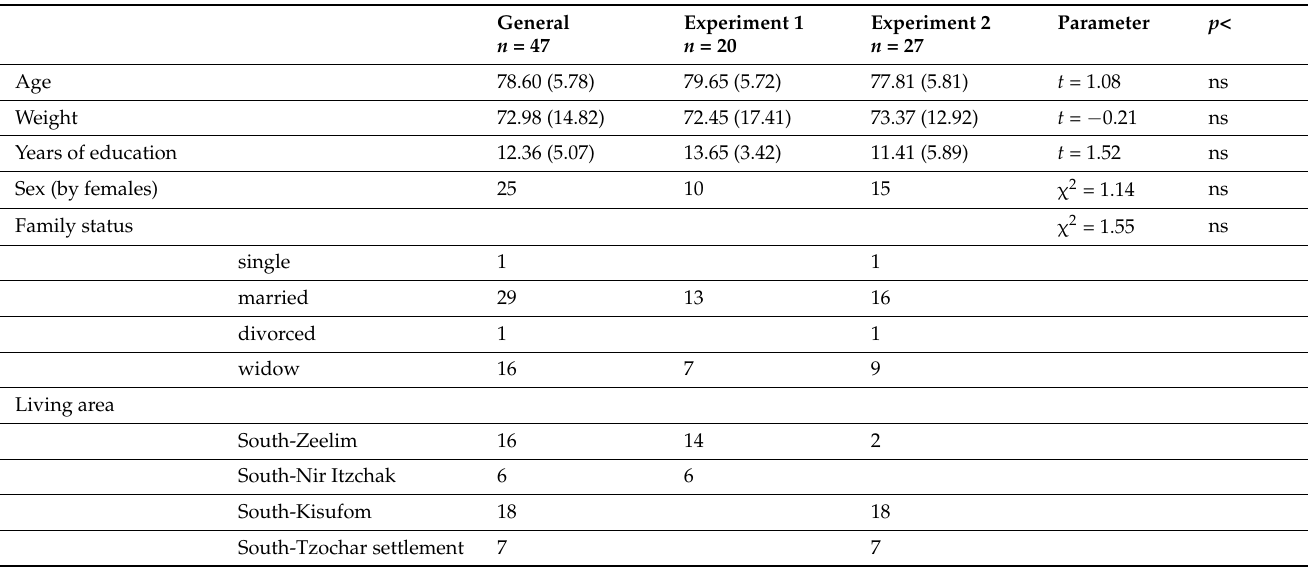
Table A4. Comparison of the old adult groups in experiments 1 and 2 according to the demo- graphic